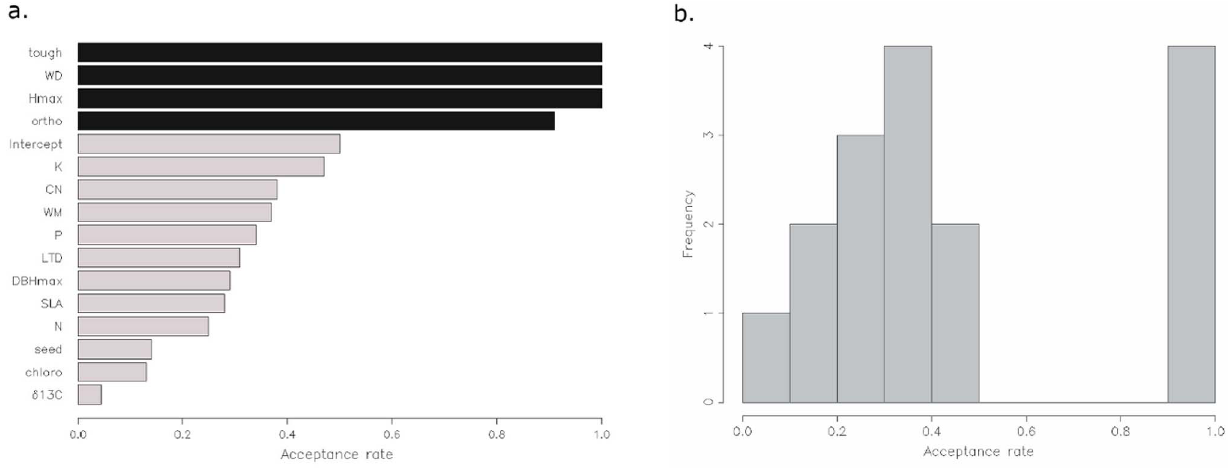
Figure 4. Results of the Kuo-Mallick algorithm for parameter selection. a: Mean of the distribution for each variable; variables are included in the final model if the mean value exceeds 90%. Variables included in the final models are: stem and branch orientation ( ortho ), maximum height ( H max ), wood density ( WD ) and laminar toughness ( tough ). b: Histogram of the results of the Kuo-Mallick algorithm for parameter selection. Acceptance rates showed a gap from 0.5 to 0.9, and variables with results above 0.9 were selected for the final model.